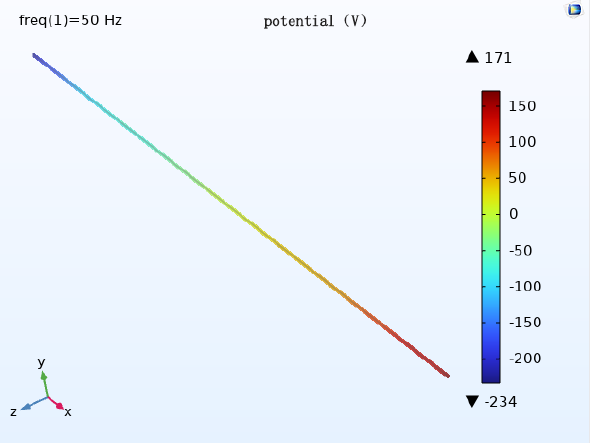
Figure 21. Distribution of cathodic protection potential when the conductors are arranged horizon- tally.